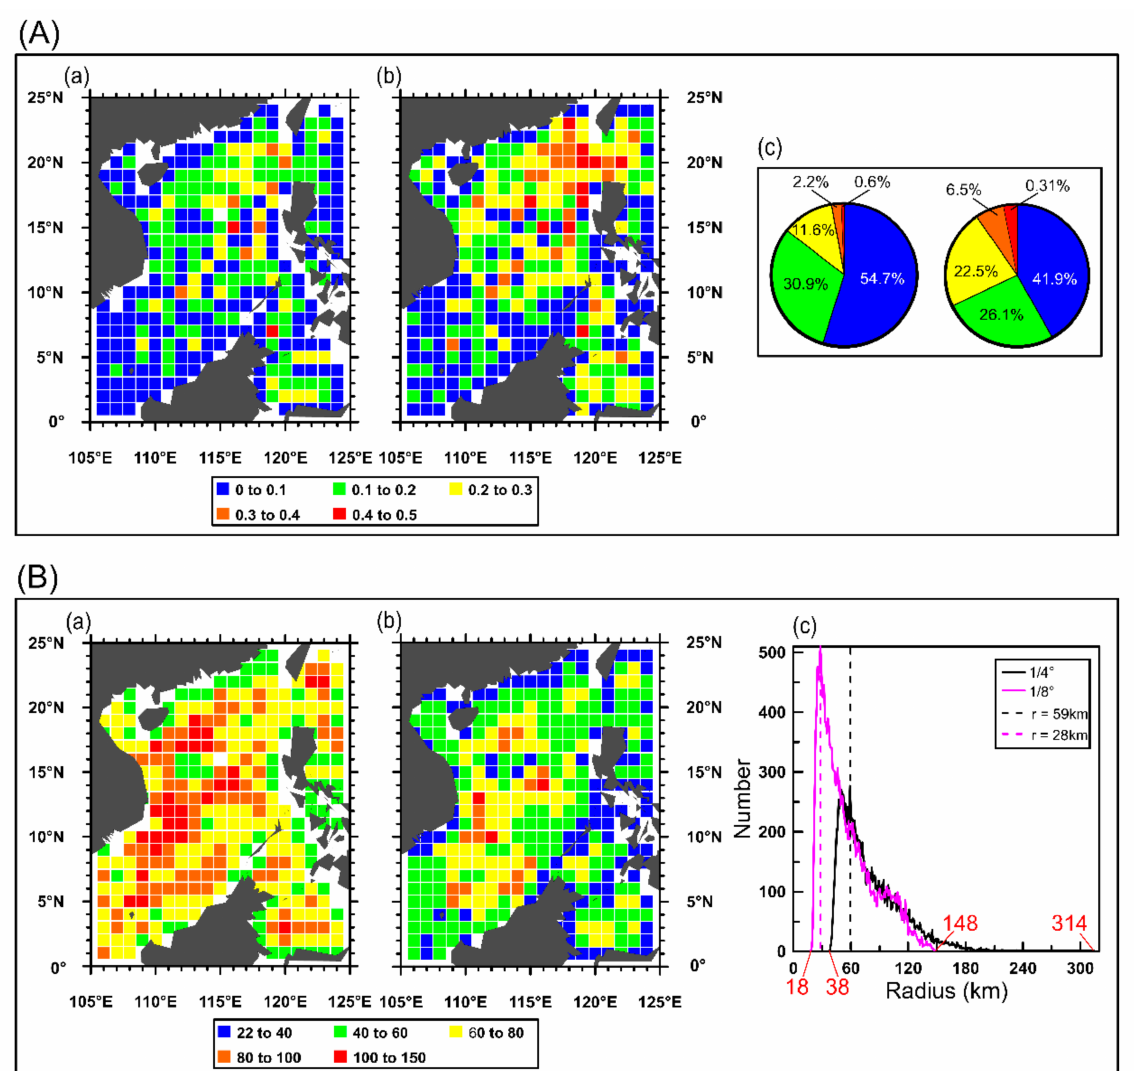
Figure 9. ( A ) Eddy density distribution maps (( a ) 1/4 ◦ ; ( b ) 1/8 ◦ ) and density ratio pie charts ( c ) in the South-China Sea. The colored squares represent the range of eddy density, as shown in the legend. The color pie charts represent the proportion of each density range and the result of 1/4 ◦ data is on the left. ( B ) Eddy radius distribution maps (( a ) 1/4 ◦ ; ( b ) 1/8 ◦ ) and radius line chart ( c ) in the South-China Sea. The colored squares represent the range of eddy radius, as shown in the legend. The histogram represents the relationship between eddy radius and number under different resolutions, where the black line represents the eddies identified using the 1/4 ◦ data, and the magenta line represents the eddies identified using the 1/8 ◦